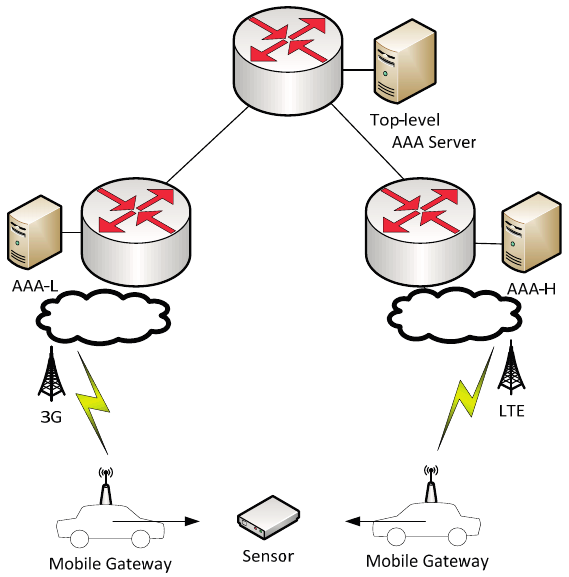
Figure 9. City environment experimental setup with fixed sensor nodes and mobile gateways connected to the cellular network